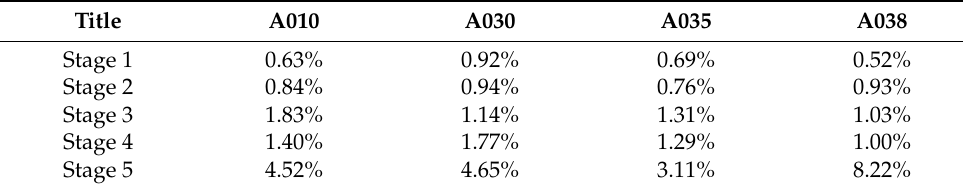
Table 4. Voids in filler